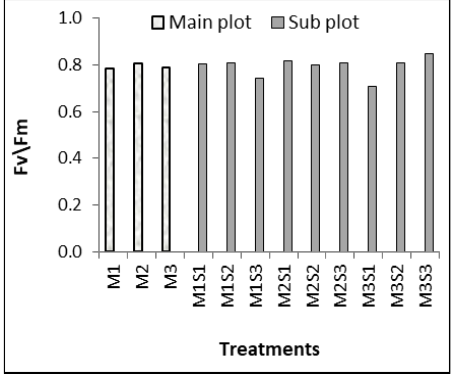
Figure-3 Fv/Fm vs Treatment